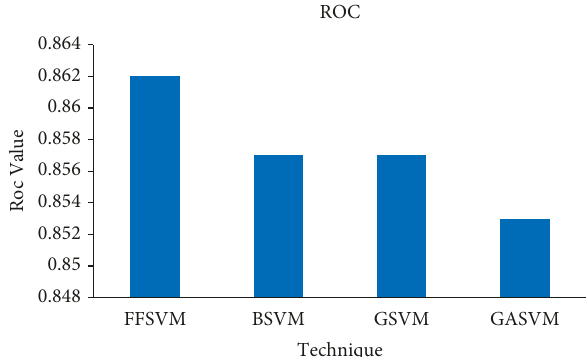
Figure 6: Comparative analysis of ROC of FFSVM, BSVM, GSVM, and GASVM techniques used to determine the quality and ef- feteness of the prediction